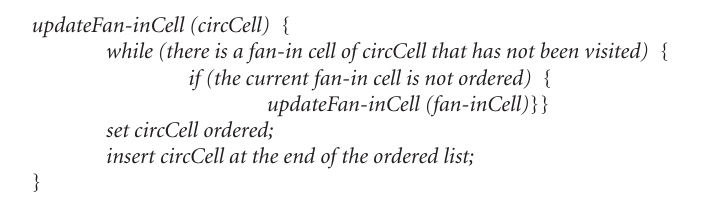
Algorithm 3: Pseudocode of the cell sorting